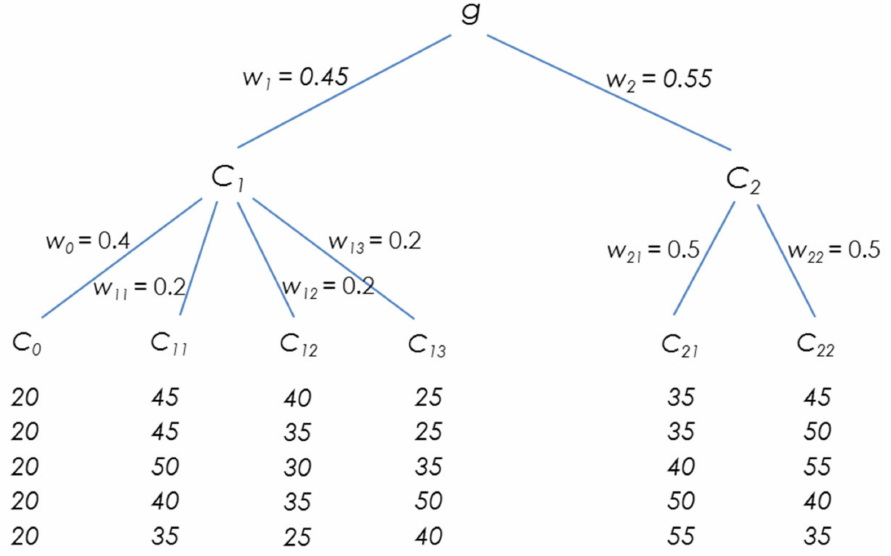
Figure 2. Illustration of Example